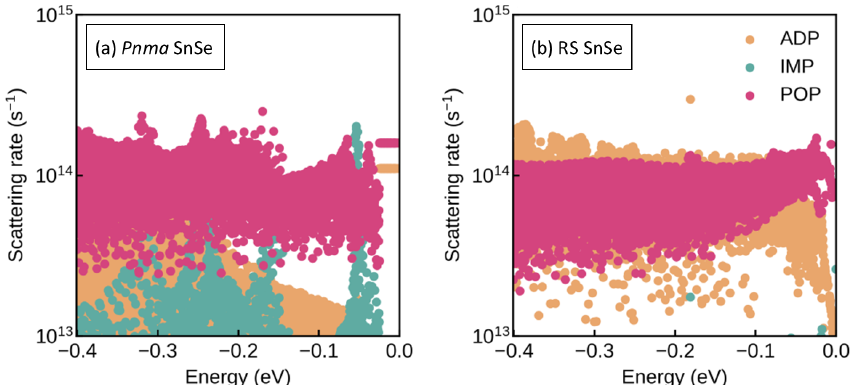
Figure 5. Calculated scattering rates τ − 1 as a function of energy (cid:101) k j for the electronic states in Pnma ( a ) k j and rocksalt SnSe (RS) ( b ) for a carrier concentration n = 2.15 × 10 19 cm − 3 and temperature T = 800 K. The energy zero is set to (cid:101) = (cid:101) F . Rates are shown separately for the three scattering mechanisms relevant to the two phases of SnSe, viz. acoustic deformation potential (ADP), polar optic phonon (POP), and ionised impurity (IMP)